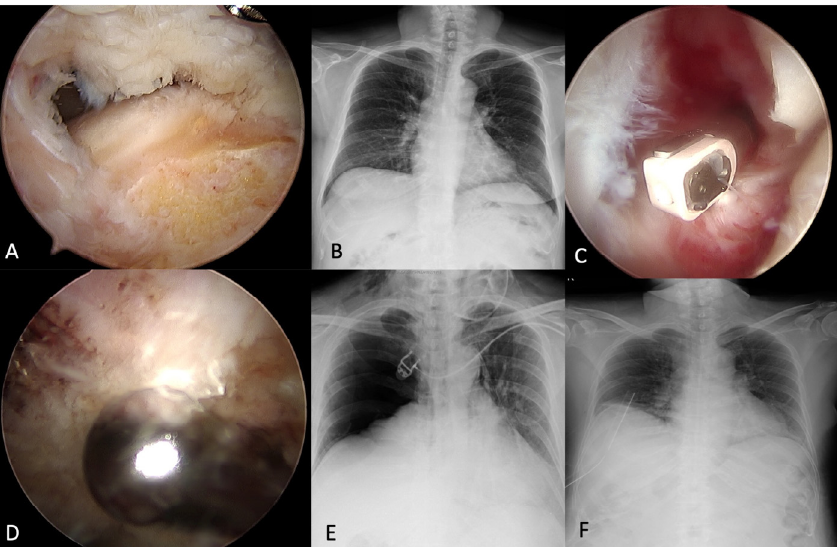
Figure 1. A 65-year-old female with ( A ) Right supraspinatus and subscapularis tears. ( B ) Preop- erative chest X-ray was unremarkable. ( C ) Rotator interval release. ( D ) Acromioplasty. ( E ) Right pneumothorax with trachea and mediastinum left shift. ( F ) A chest tube was placed smoothly without